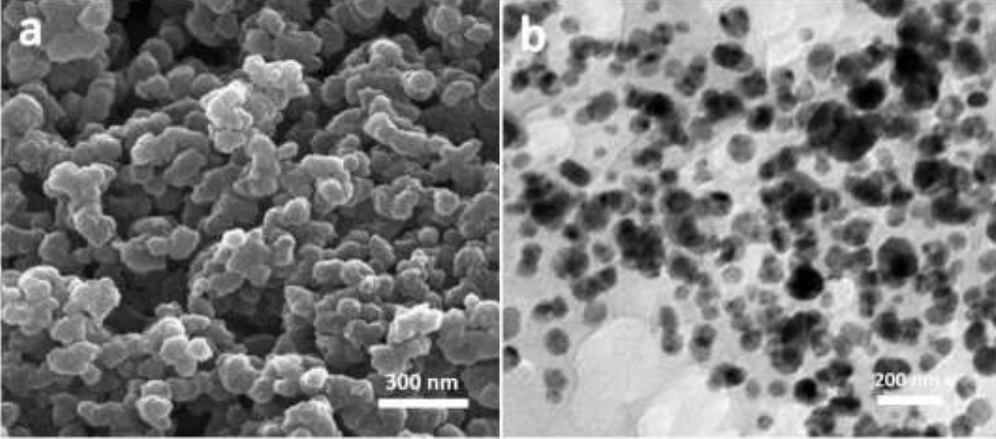
Figure 1: SEM (a) and TEM (b) images of synthesized gamma-alumina.